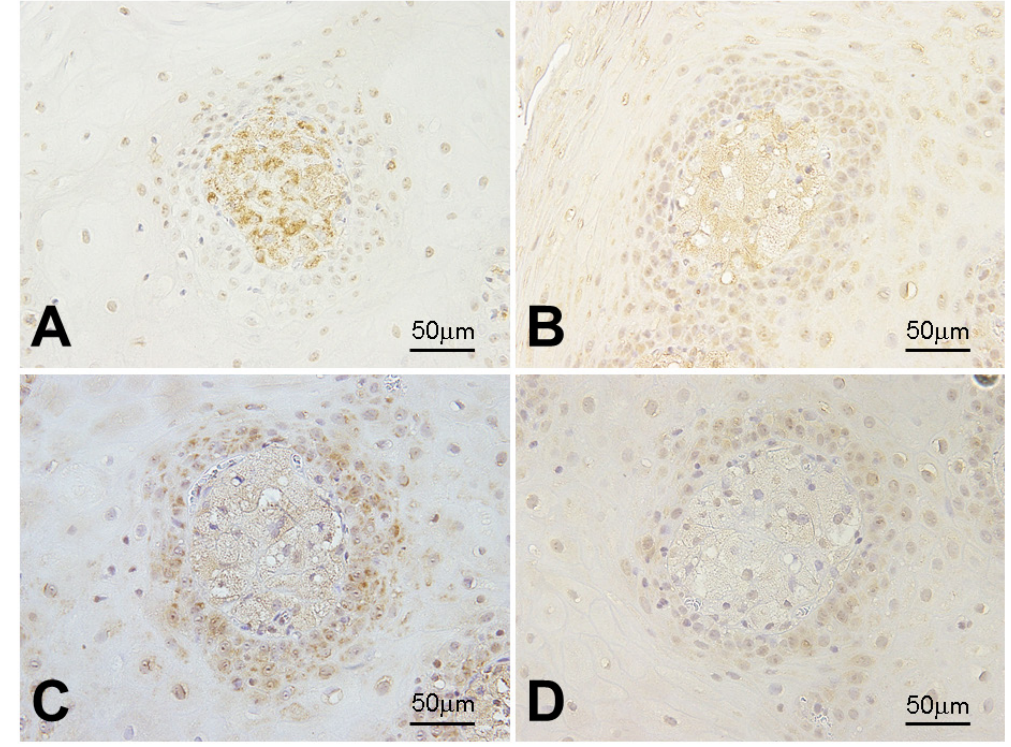
Figure 3: Expression of macrophage lineage markers in foam cells. Foam cells in xanthoma are strongly positive for CD68 (A, x400), modera- tely positive for CD163 (B, x400) and TGF-β (C, x400), and weakly positive for iNOS (D,